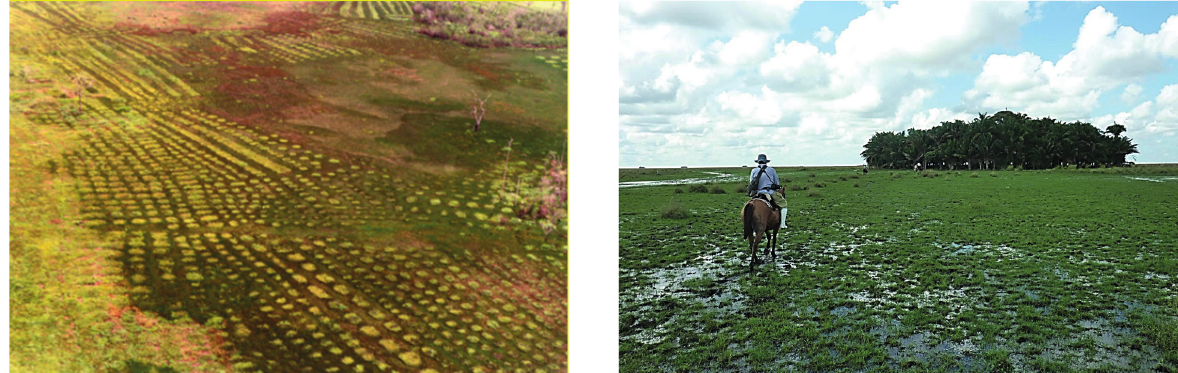
Figure 1 - Examples of the lasting ecological legacy left by pre-Columbian Amazonians in seasonally fl ooded savannas. Left panel: pre-Columbian wetland raised fi elds in seasonally fl ooded coastal savannas in French Guiana. Photo courtesy of Stéphen Rostain, CNRS, Paris, France. Right panel: A human-made forest island in seasonally fl ooded savanna in the Llanos de Mojos, Bolivia. Photo by the